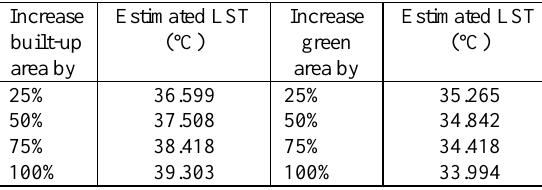
Table 4: Estimated LST value if both parameters are increased by 25%, 50%, 75% and 100% of the current built-up area and green areas in Kampung Baru.